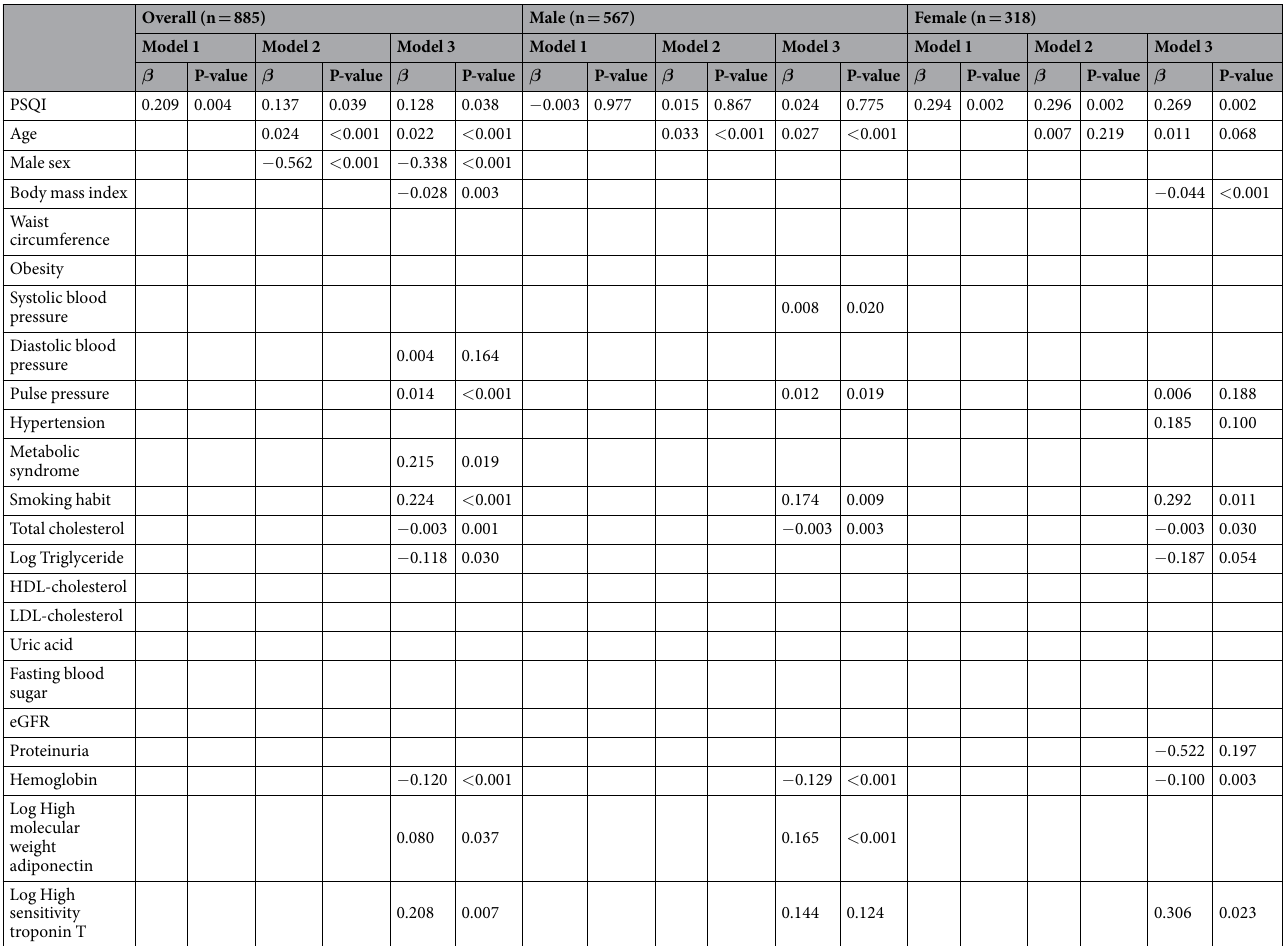
Table 4. Multivariate analysis of the association between NT-proBNP and PSQI. In overall analyses, Model 1 was un-adjusted analyses, Model 2 was multivariable analyses which were adjusted for age and sex, and Model 3 was multivariable analysis which were adjusted for age, sex, BMI, diastolic blood pressure, pulse pressure, metabolic syndrome, smoking habit, total cholesterol, logarithmic triglyceride, hemoglobin, logarithmic high molecular weight adiponectin and logarithmic hsTnT. In subgroups of male and female subjects, Model 1